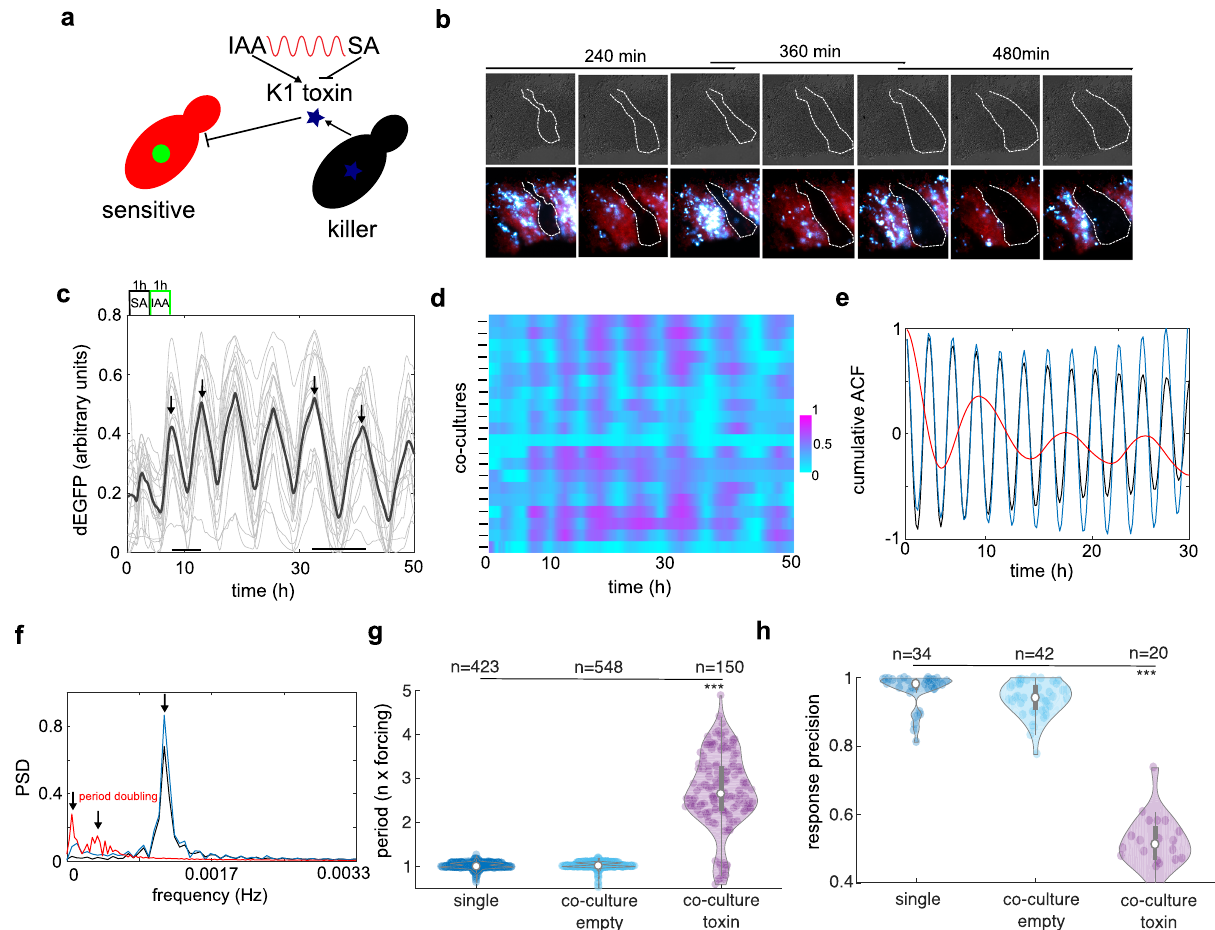
Fig. 5 Synthetic yeast consortium maintains synchrony under chaotic regime in the presence of pulsatile toxin stress. a Schematics of designed synthetic yeast ecosystem driven by SA-IAA chemical clock. Two sister strains one producing green reporter (sensitive, red) and other producing K1 toxin (blue star) coexists under rhythms of IAA and SA. b Snapshots from time-lapse micro fl uidics experiments with co-cultured sensitive and killer strains under 2h-lasting input pulses. Note successive period doublings in three successive cycles. Dark regions with dashed borders represent killer strain adjacent to sensitive counterparts (red and cyan). c , d Time-lapse pro fi les of dEGFP with mean trends (right panel black lines) for sensitive strain ( c ) and corresponding cold heat map (cyan-purple) with normalized reporter between 0 and 1 ( d ). Note, period doublings (arrows) and simultaneous prevalence of synchrony between recorded communities in the micro fl uidic chip ( n = 20). e Cumulative autocorrelation function for sensitive strain grown alone (black line, reference), co-cultured with strain carrying empty plasmids (blue line) and co-cultured with killer toxin-producing strain (red line), note the absence of period doubling in toxin-free ecosystems. f Power spectra density demonstrate left shifts towards lower frequencies (period doublings) in toxin-producing co-cultures (red line) as compared to controls (black and blue lines). g Distribution of period doublings in the sensitive strain grown alone, or with coculture with and without toxin producing sister strain. (*** p -value = 1.1 − 10 , a one-way ANOVA with post-hoc Tukey ’ s HSD). h Response precision drops by nearly 50% in the co-culture experiments with toxin producing strains but not in the controls (*** p -value = 1.1 − 10 , a one-way ANOVA with post-hoc Tukey ’ s HSD). The description of violin plots is as in Fig. 1f. Source data are provided in the Source Data fi